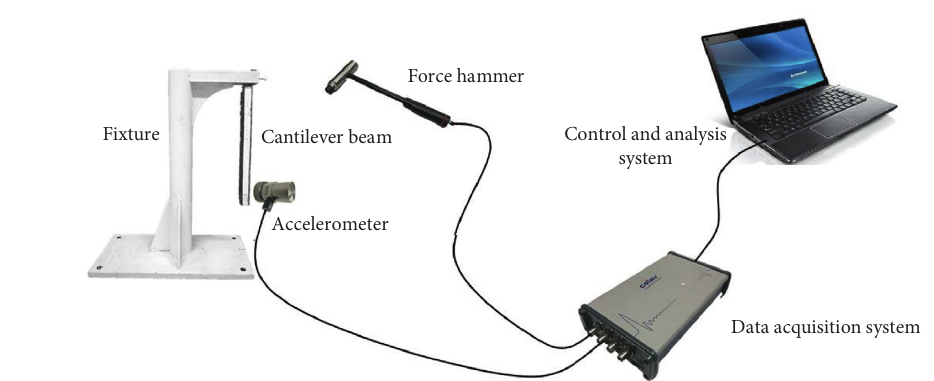
Figure 3: Test and analysis system.